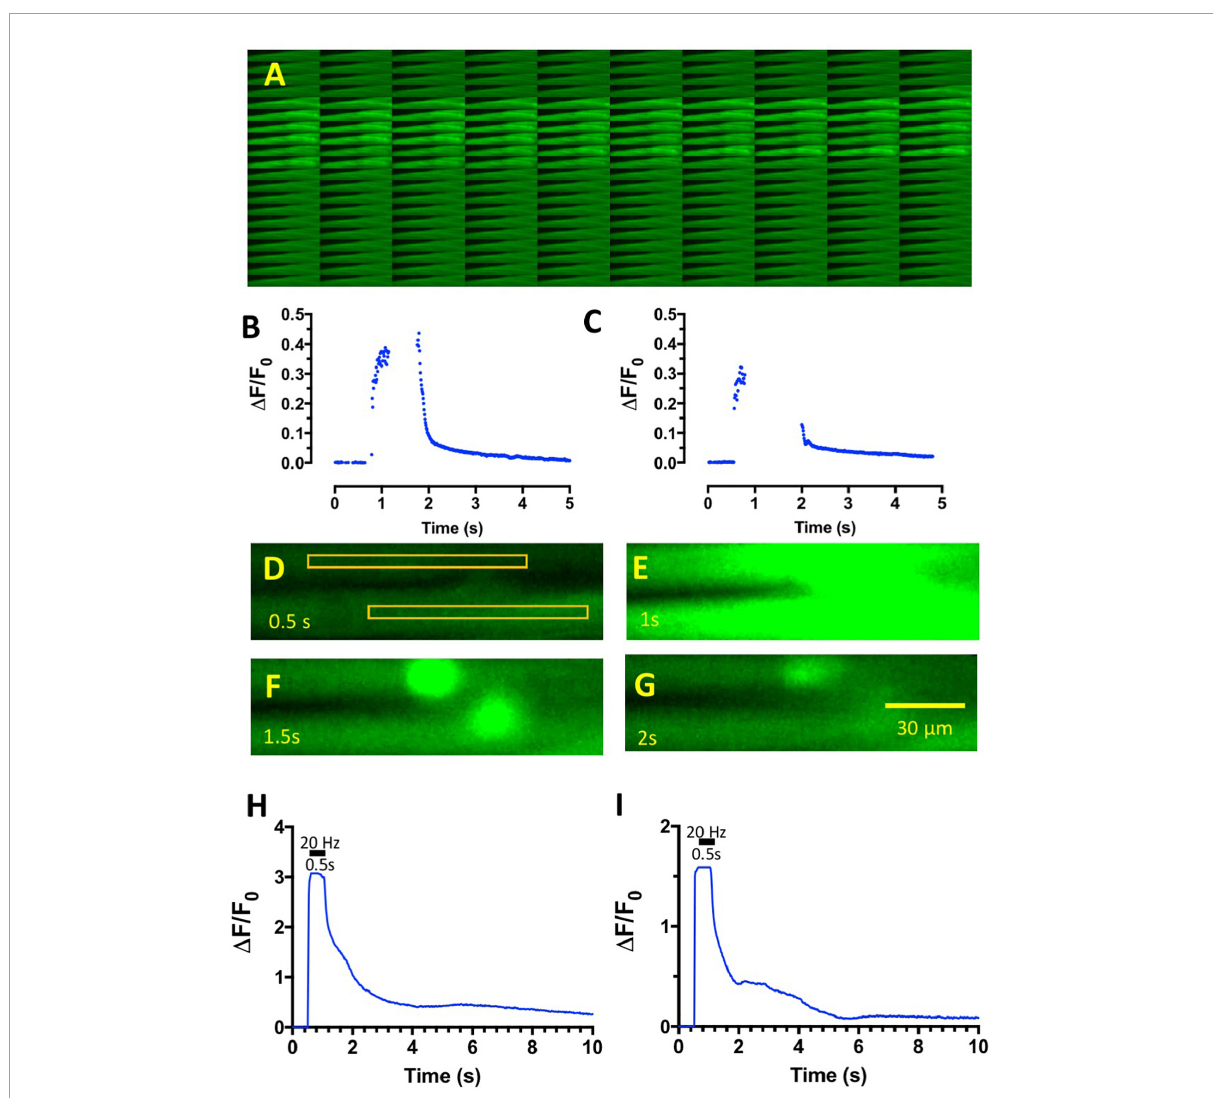
FIGURE4 Tetanic stimulation of muscles incubated in omethoate causes complex endplate Ca 2 + transients. (A) Montage of sequential images of an FDB muscle in control MPS solution during 1 s tetanic stimulation at 20 Hz. Bright region shows the period of increased Fluo-4 fluorescence, which was limited to the period of stimulation. Images captured at 100 fps. (B) Graph of fluorescence intensity (arbitrary units) against frame number (100 fps) of the images captured in panel (A) , showing the brisk onset and decay of intracellular Ca 2 + associated with the tetanic stimulus train. Peak fluorescence data were discarded due to movement of the preparation in the image plane. (C) Similar data from a different preparation in control MPS. (D–G) Selected, sequential image frames (f25–f100: frames 25, 50, 75, and100 in Supplementary Video 3 ) from two FDB muscle fibers in a preparation loaded with Fluo-4 after incubation in 150 µ M omethoate for 1 h then stimulated at 20 Hz for 0.5 s. Rectangles in panel (D) show the regions of interest (ROI) defined for measurement of average pixel intensity before (D) , during (E) , and after (F,G) tetanic stimulation. Note the persistence of endplate fluorescence in panel (F) and its subsequent slow decay. (H,I) Graphs of the upper (H) and lower (I) ROIs indicated in panel (D) over the duration of the recording shown in Supplementary Video 3 . The period of stimulation (20 Hz, 0.5 s) is indicated by the horizontal bar. Images were captured at 50 fps. Note the complex profile of post-tetanic decay of fluorescence, due in part to prolonged, persistence fluorescence of the two NMJs contained in the image